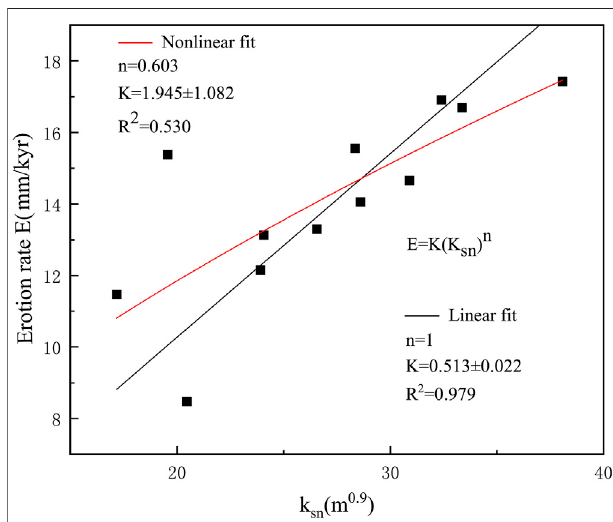
FIGURE 7 | Linear and nonlinear fi tting between catchment-averaged erosion rates ( y -axis) and steepness indices ( x -axis). The results of fi tting indicate a better relevance in linear fi tting than nonlinear fi tting.